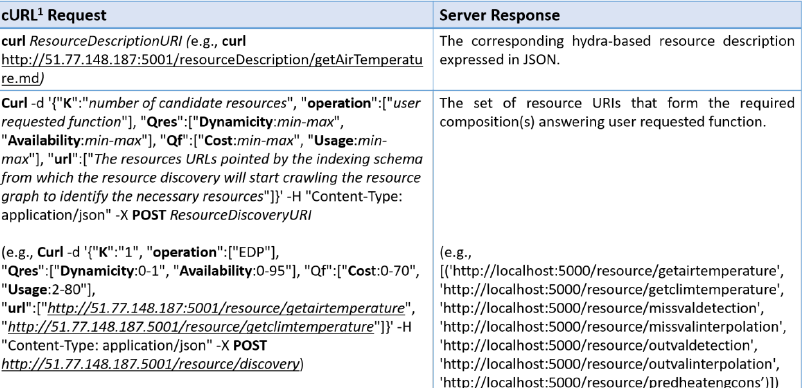
Figure 7. The visual representation obtained in OpenCEMS of the composition example related to our motivating scenario.